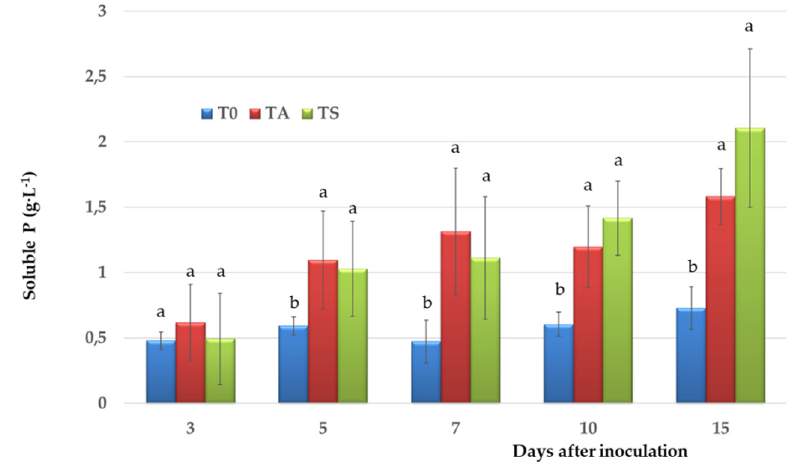
Figure 2. Effects of Trichoderma aggressivum f. europaeum (TA) and Trichoderma saturnisporum (TS) on phosphate solubilisation in National Botanical Research Institute’s phosphate (NBRIP) broth containing tribasic calcium phosphate (10 g). T0: NBRIP broth without Trichoderma isolates. The results are shown as the average of the three replicates, in g L − 1 . Mean standard deviation is expressed in the error bar ( n = 3). For each isolate, columns marked with different letters indicate a significant difference at p < 0.05.